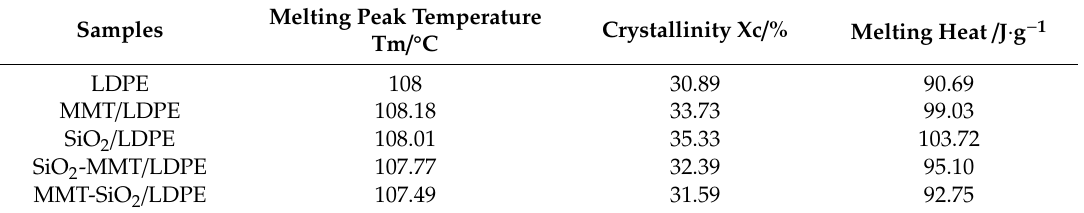
Figure 4. DSC curves of composite materials. Table 1. Melting peaks and crystallinities of all samples.